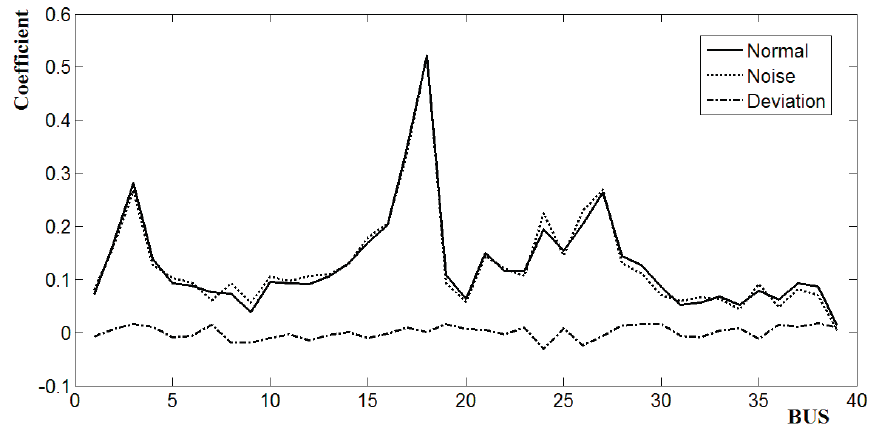
Figure 2. The noise influence in asymmertical short circuit